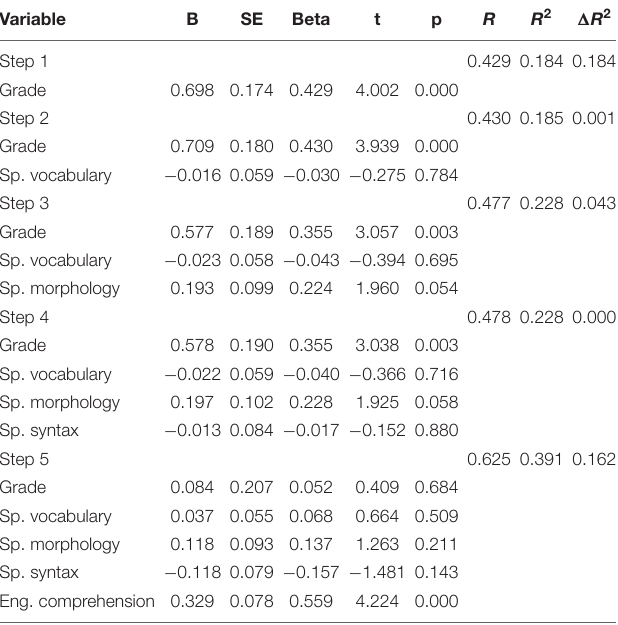
TABLE 4 | Summary of hierarchical multiple regression analysis for variables predicting the outcome Spanish reading comprehension.